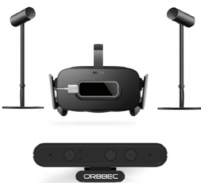
Figure 2. Peripheral hardware of the Virtual Reality-Motion Camera (VR-MC) system.